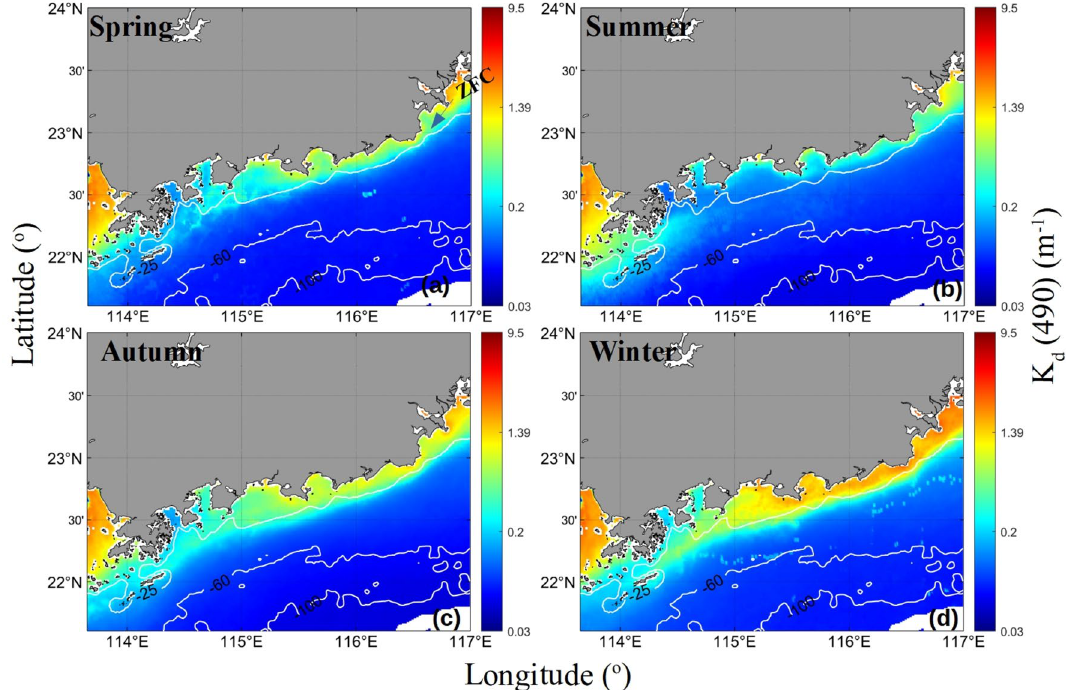
Figure 2. The seasonal mean K d (490) values (m −1 ) in four seasons from 2003 to 2017. The program R (version 3.6.3, available at https:// www.r- proje ct. org) was applied for the archipelago in the SCS. Based on long-term K d (490) observations, the fronts were found to be prominent in November and December. The mean K d (490) between November and December from 2003 to 2017 is given in Fig. 3. Coastal fronts existed almost every year from 2003 to 2017. However, the lengths, directions and intensi- ties of the fronts differed among different years. The strongest front was observed in 2005. The fronts were too weak to be distinguished in 2009. In 2005, the front was very sharp and narrow. The distributions of the mean K d (490) in the EGD coastal waters with depths less than 25 m between November and December 2005 are given in Fig. 4. The meridional distribution of the mean K d (490) values at 22.5°N and 22.2°N are given in the plots on the left, and the zonal distributions of the mean K d (490) values at 114.7°E and 114.4°E are given in the plots on the right. Noticeable peaks can be seen in the plots, and there is clear evidence that a significant discontinuity existed in the region. The widths of the fronts tended to decrease with decreasing latitude. The cross-frontal dif- ferences in K d (490) reached 3.7 m −1 . The outer edge of the front was smooth, and the demarcation line between the lower and higher K d (490) values in EGD was clear and was parallel to the coastline. The front contained obvious intensity gradients. In contrast, the front was not obvious in 2009. In 2009, the edge of the front was not sharp but was slightly occluded or mottled.